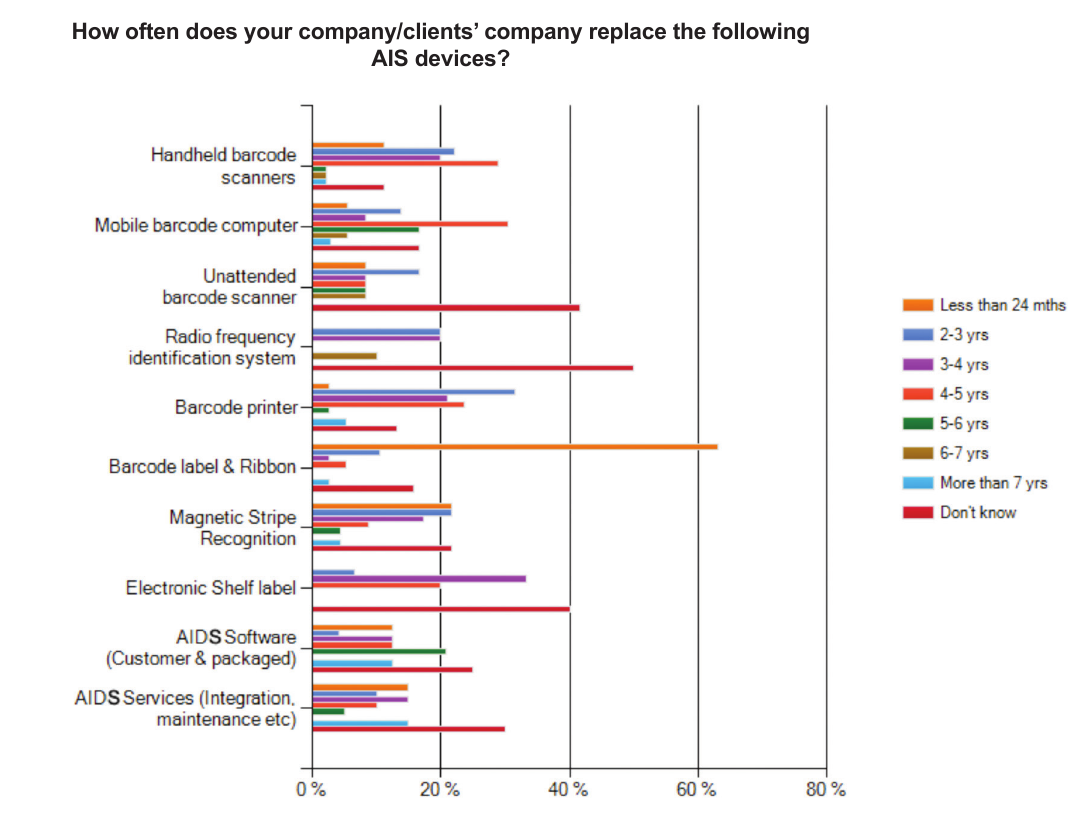
Figure 2: Replacement of AIS